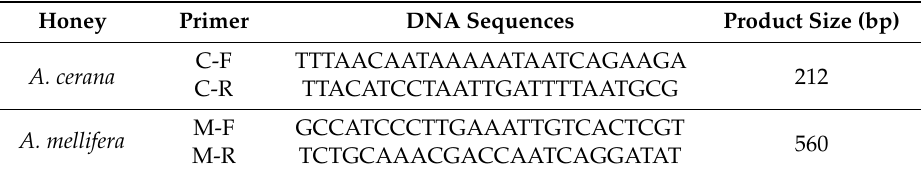
Table 1. Primers used for polymerase chain reaction (PCR)